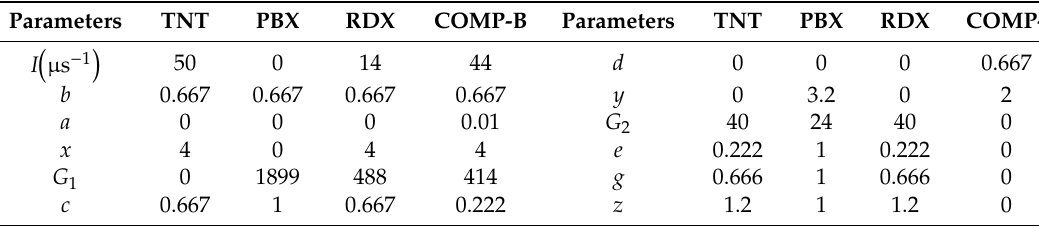
Table 2. Reaction rate parameters of explosives (PBX, RDX, COMP-B and TNT). Parameters